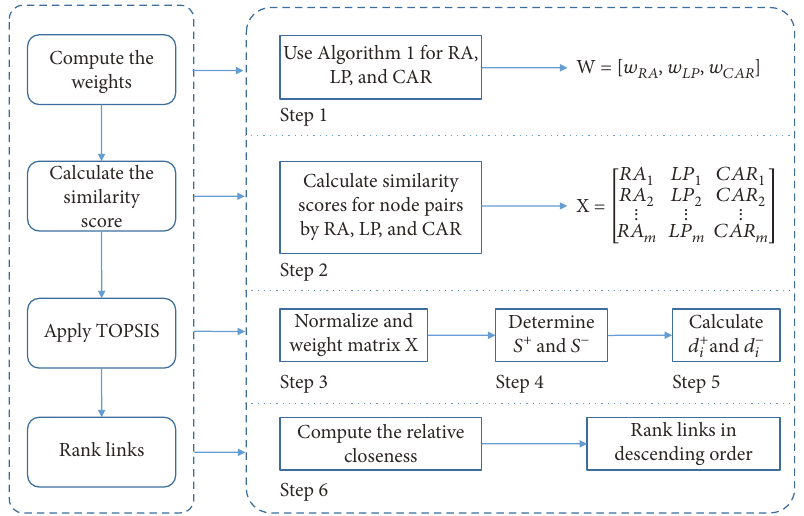
Figure 1: The fl ow chart of the proposed